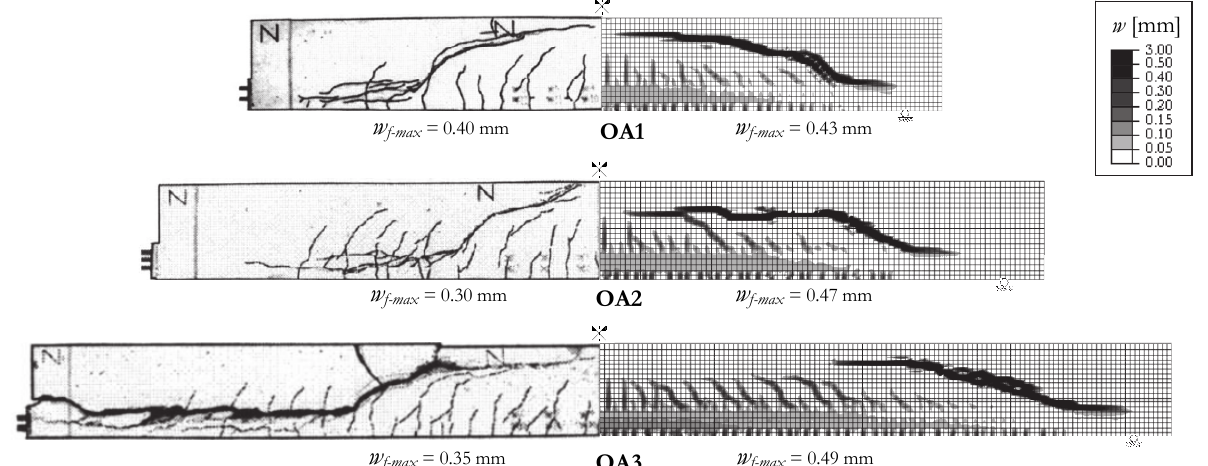
Figure 5: Experimental (left side, [17]) vs numerical (right side) crack patterns and crack widths at failure for specimens